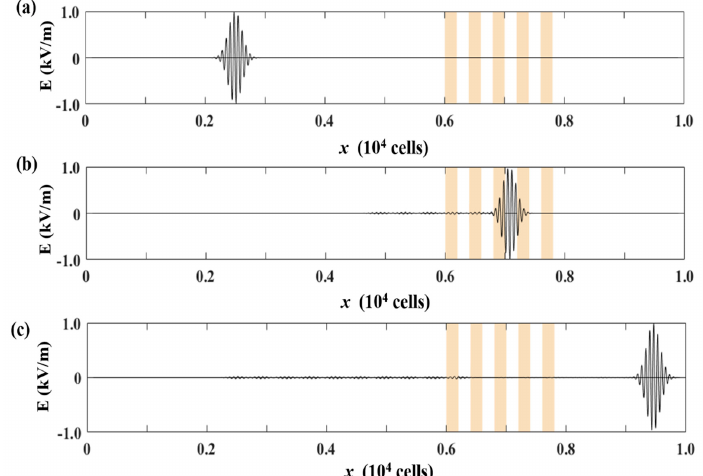
Figure 9. Simulation of a wave propagating in air and striking 1D plasma PhCs with plasma layer thickness d = 200 nm. The plasma has the properties of silver: ω p = 2000 THz, ϑ c = 50 THz. The propagating wave has a center frequency of 4000 THz. ( a , b ) show electric field in the computational domain at different times ( a ) = 0 fs, ( b ) = 15 fs, and ( c ) = 23 fs. (Left side with film thickness of 1000 cells, right side with film thickness of 2000 cells).